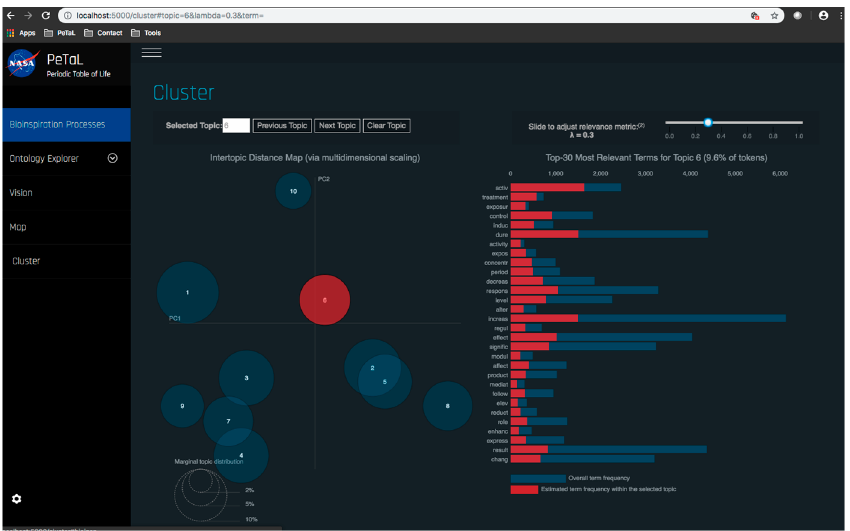
Figure 31. Topic modeling tool in PeTaL that automatically groups biological functions to form functional groupings for a bag of words approach.